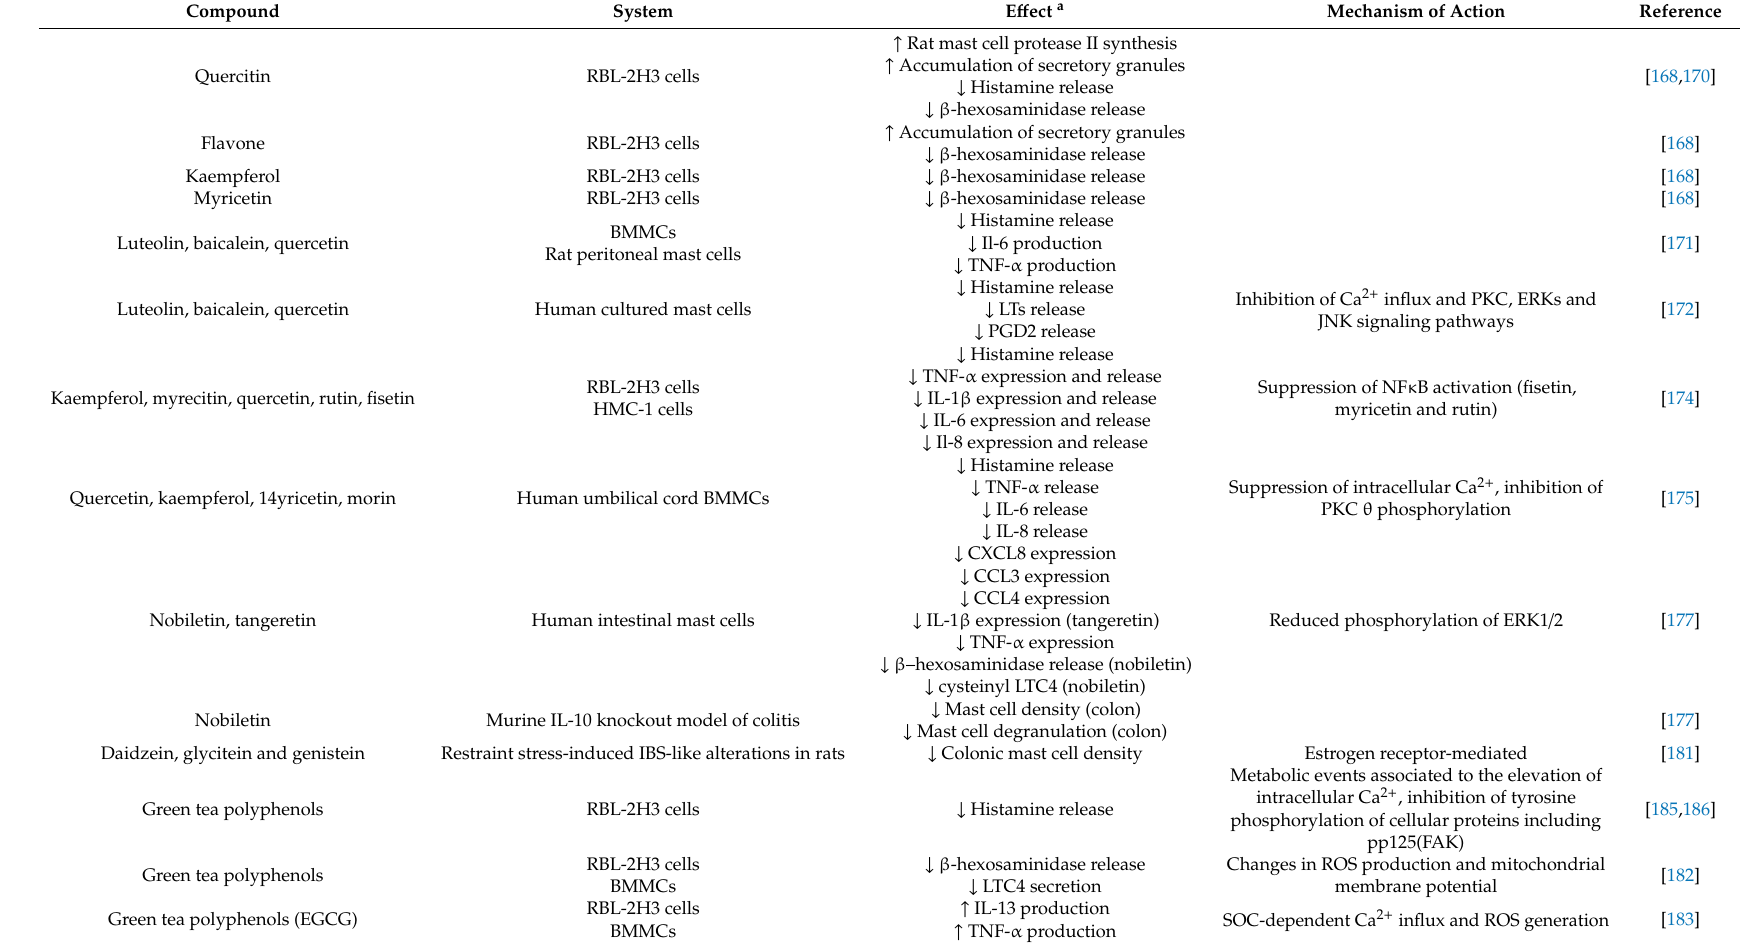
Table 7. Immunomodulatory e ff ects of polyphenolic compounds on mast cell